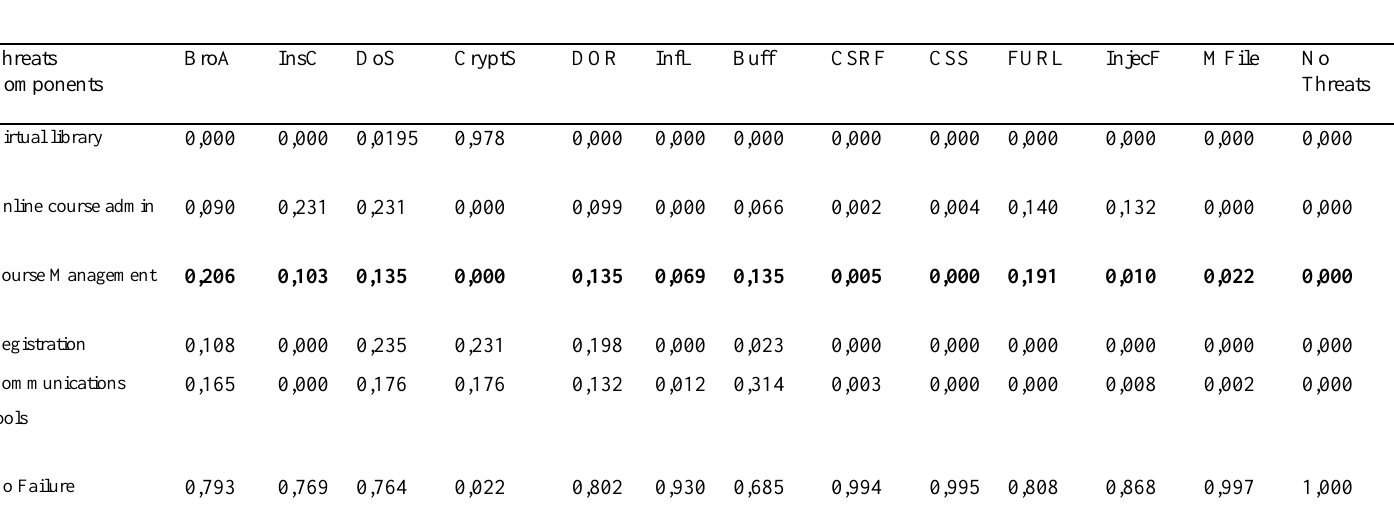
Table 4: The FCT matrix